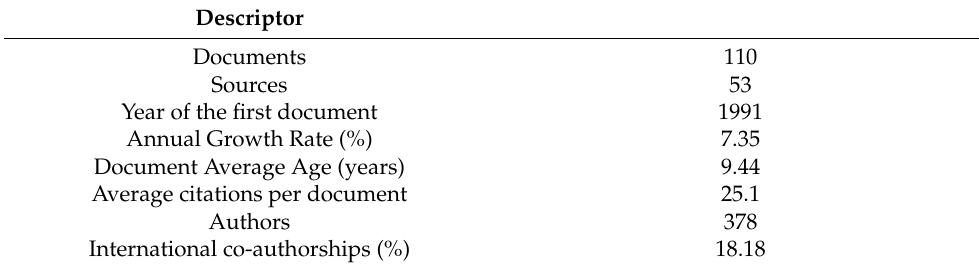
Table 2. Main descriptors of the retrieved documents employed for this review.